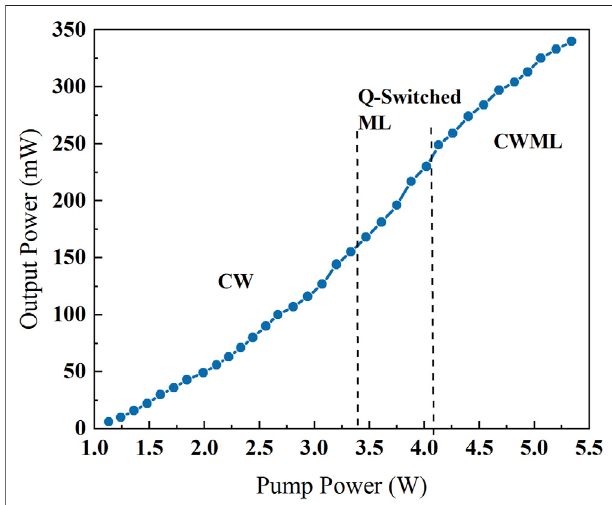
FIGURE 3 | Measured output power and operation mode versus incident pump power at 2,347 nm center wavelength. CW, continuous wave; Q-switched ML, Q-switched mode-locking; CWML, continuous wave mode- locking.